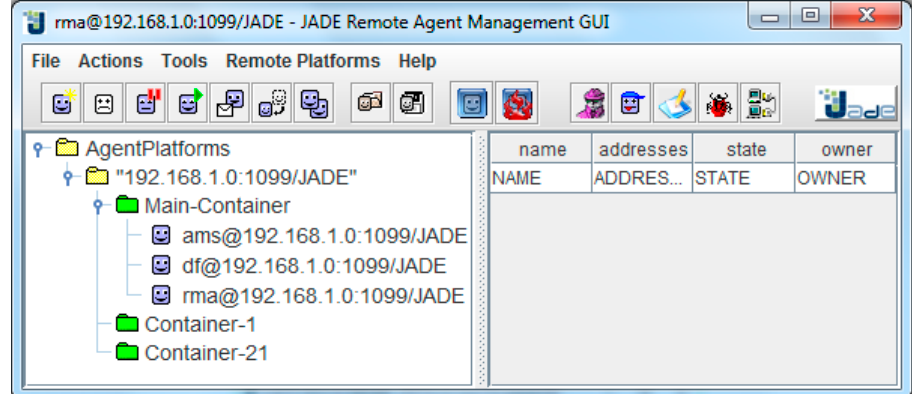
Figure 6. The GUI of the Main Container.